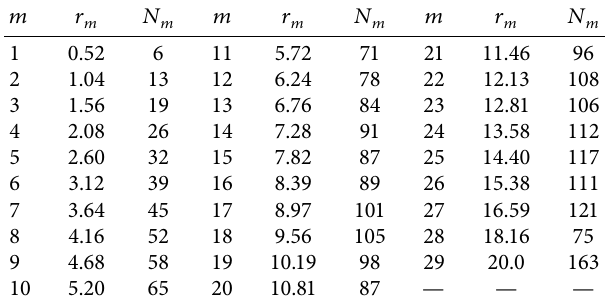
) and number of elements ( N m